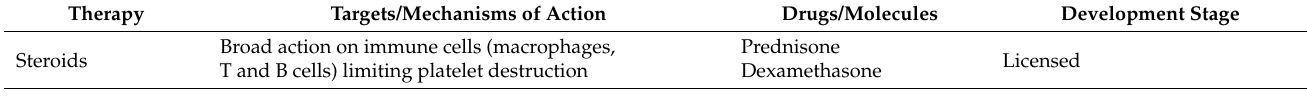
Table 1. Current and emerging therapies of